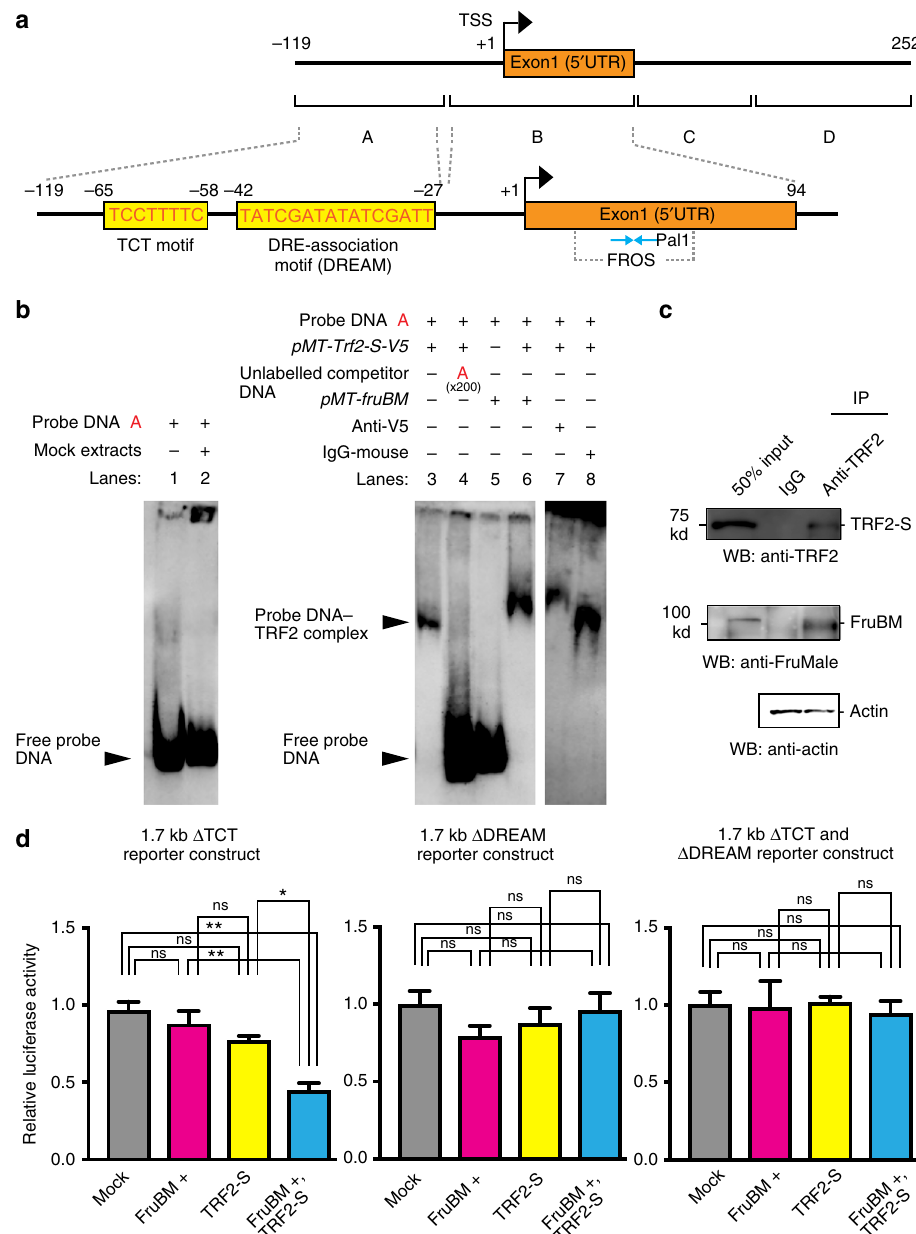
Fig. 5 TRF2-S and FruBM interact with the robo1 promoter. a Upper panel: the map of the robo1 genomic region (upper line) and the positions of fragments A – D (lower line) used for electrophoretic mobility shift assays. Exon 1 is highlighted in orange. Transcription starts at the site and in the direction indicated by the arrow. Lower panel: the exon 1 and fl anking regions with the TCT motif and DREAM are shown in an expanded scale. The location of FROS is indicated below exon 1. The two moieties of Pal1 as the core FruBM-binding motif are indicated by the blue arrows facing each other. The sequences composing the TCT motif and DREAM are indicated by red capitals. b Retarded migration of probe A was observed in the presence of S2 cell lysates expressing TRF2-S (TRF2-S[+] lysates, lane 3), but was not observed without lysates (lane 1) or with lysates expressing an empty vector (lane 2). The retarded band was diminished when an unlabeled probe A was added as a competitor (lane 4). Cell lysates expressing FruBM alone (FruBM[+] lysates, lane 5) did not yield any retarded band, whereas cell lysates expressing both TRF2-S and FruBM (TRF2-S[+]/FruBM[+] lysates, lane 6) did. The retarded band was supershifted when preincubated with a mouse anti-V5 antibody (lane 7), but not when preincubated with a mouse IgG antibody (lane 8). c Coimmunoprecipitation of TRF2-S and FruBM. Lysates from S2 cells co-transfected with Trf2-S and fruBM were subjected to immunoprecipitation with the anti-TRF2 antibody and analyzed by western blotting with the anti-TRF2 and anti-FruMale antibodies. Actin served as a loading control. d Luciferase reporter assays with the 1.7 kb robo1 promoter region lacking TCT ( Δ TCT), DREAM ( Δ DREAM), or both ( Δ TCT and Δ DREAM) in S2 cells transfected with the empty vector (Mock), fruBM alone (FruBM), Trf2-S alone (TRF2-S), or fruBM plus Trf2 (FruBM + TRF2-S). All experiments were conducted as triplicate and the mean ± SEM of relative luciferase activities are shown. Statistical differences were evaluated by one-way ANOVA followed by the Bonferroni ’ s multiple comparison test. ** P < 0.01, * P < 0.05; ns not signi fi